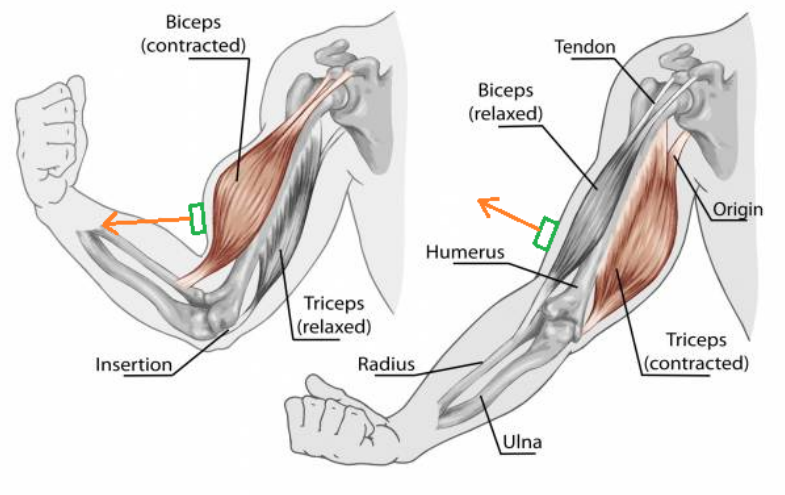
Figure 2. Sensor placement